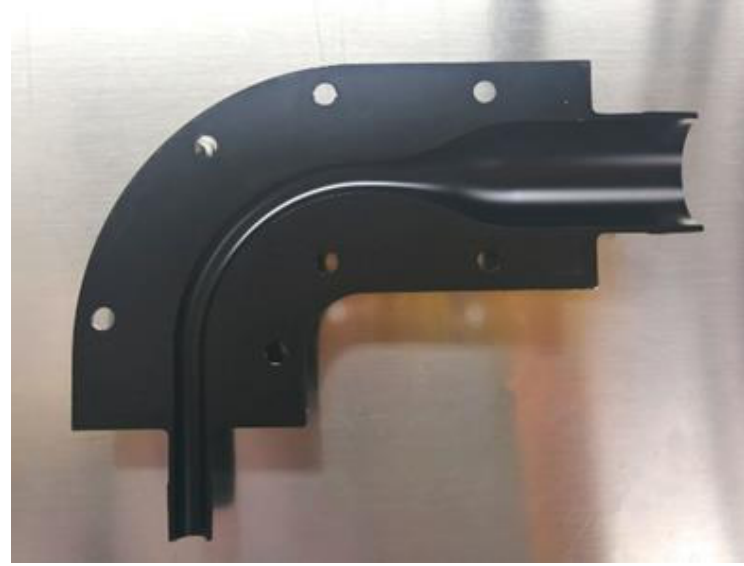
Figure 3. Photograph of the idealized mouth-throat